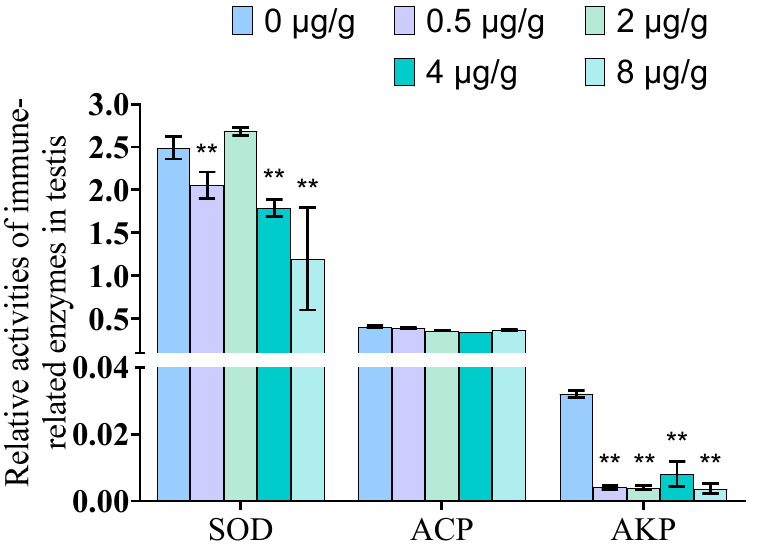
Figure 8. Enzyme activity detection of immunity-related factors. The enzyme activities of SOD and AKP in the testis decrease significantly, and ACP was no significant changed (** indicates significant compared with control group Significance. **: p < 0.01).